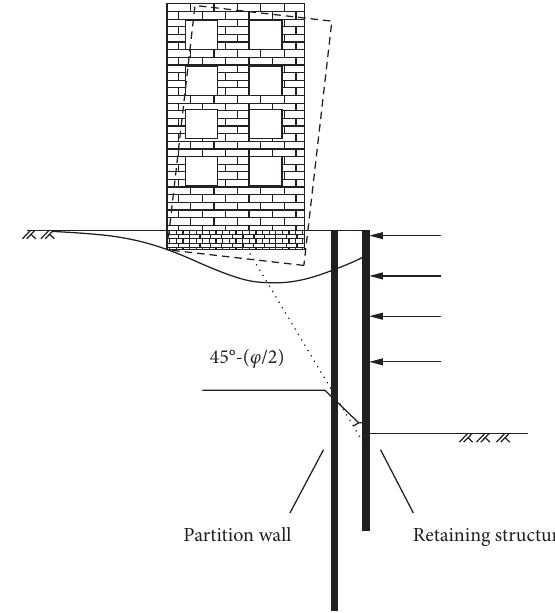
Figure 1: Schematic for the layout of the partition